Question: Summarize what this figure shows in one sentence.
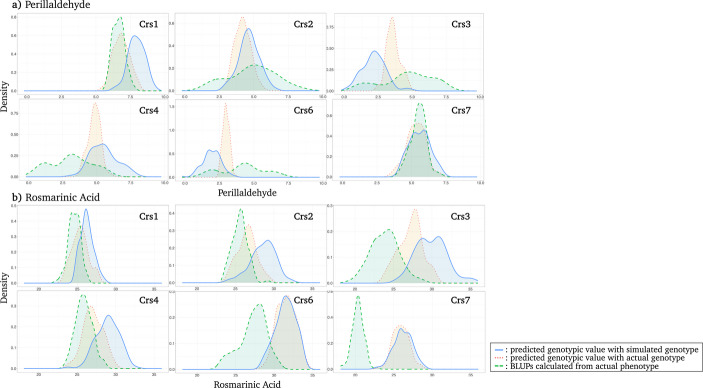
Answer: Comparison between simulated and realized progeny distributions for perillaldehyde and rosmarinic acid. The comparison was conducted for the progeny-based selected cross pairs, Crs1–Crs7. Because Crs5 was considered a failed cross, it was excluded from the figure. Panels ( a ) and ( b ) show the distributions for perillaldehyde and rosmarinic acid, respectively. For each cross and trait, three distributions are shown: blue distributions with solid lines represent predicted additive genotypic values based on simulated genotype data, orange distributions with dotted lines represent predicted additive genotypic values based on actual G₂ genotype data with inferred axllele origins, and green distributions with dashed lines represent BLUPs of the G₂ generation calculated using actual G 2 phenotype data